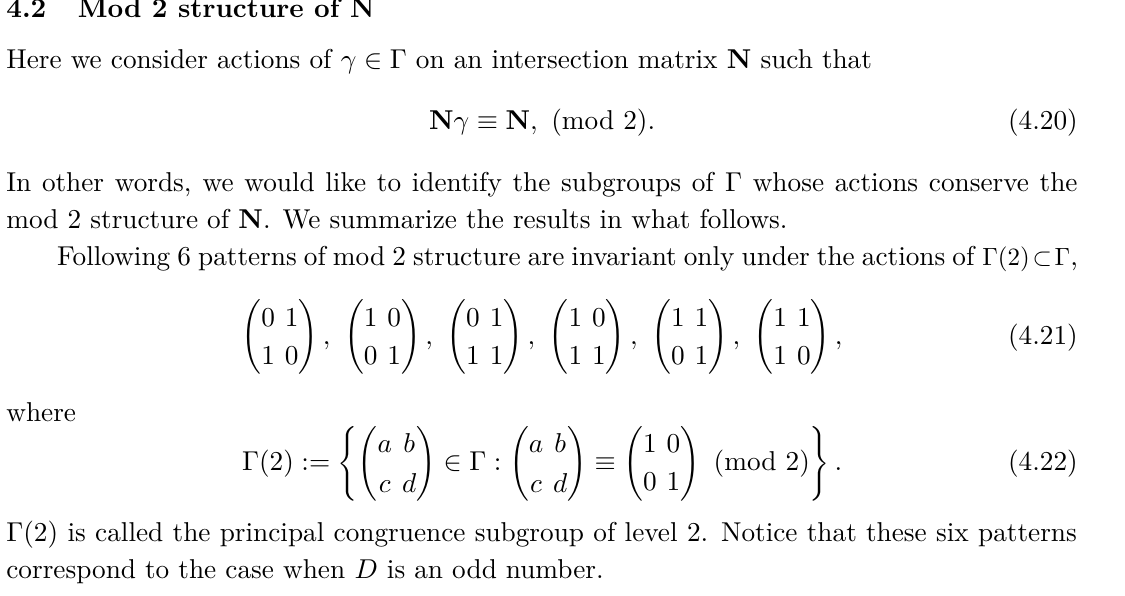
(cid:1) (cid:0) 1 (cid:1) (cid:0) 1 (cid:1) , , 0 , , 1 2 2 2 2